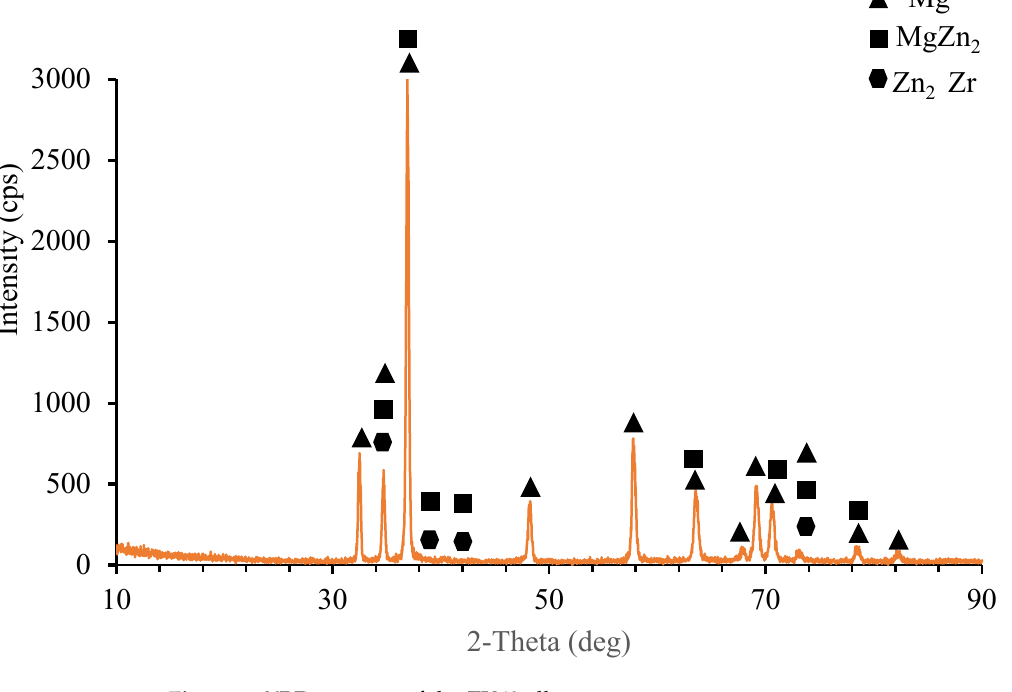
Figure 5. XRD patterns of the ZK60 alloy.